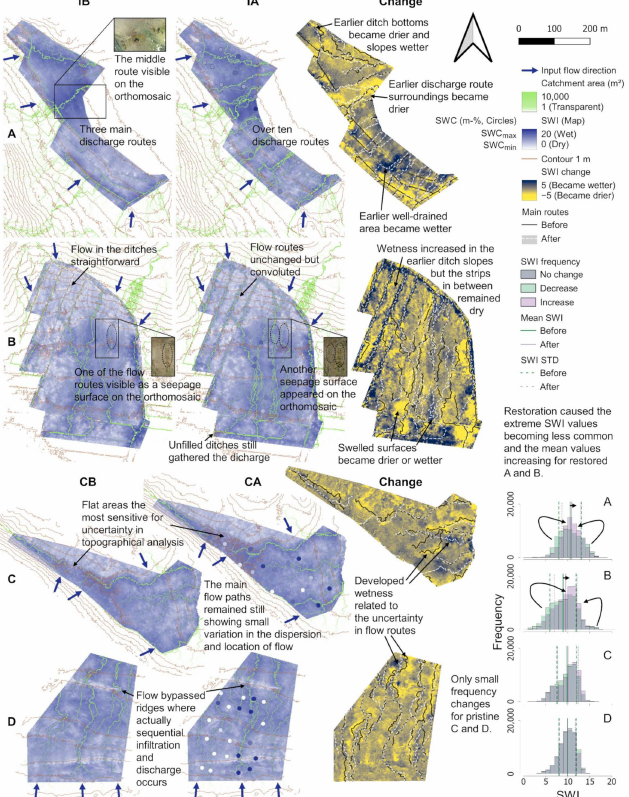
Figure 8. Wetness and flow path changes between the IB and IA campaigns in Loukkusuo ( A ) and Iso Leväniemi ( B ) and between the CB and CA campaigns in Tammalampi ( C ) and Kirkaslampi ( D ). The flow accumulation map (i.e., the catchment area upslope for each pixel) is drawn on top of the SWI map. A similar water input (upslope flow accumulation) to the processing boundary was assumed for both states. The changes are assumed to be caused by restoration (for A , B ) or mapping errors and natural changes in the surface (for C , D ). The histograms include SWI distributions for both states so that the frequency changes between the two campaigns can be elaborated from no-change. The circles fitting well with the surrounding wetness map represent a good correlation between the topography-predicted SWI and the field-measured SWC (see Table 4, d for